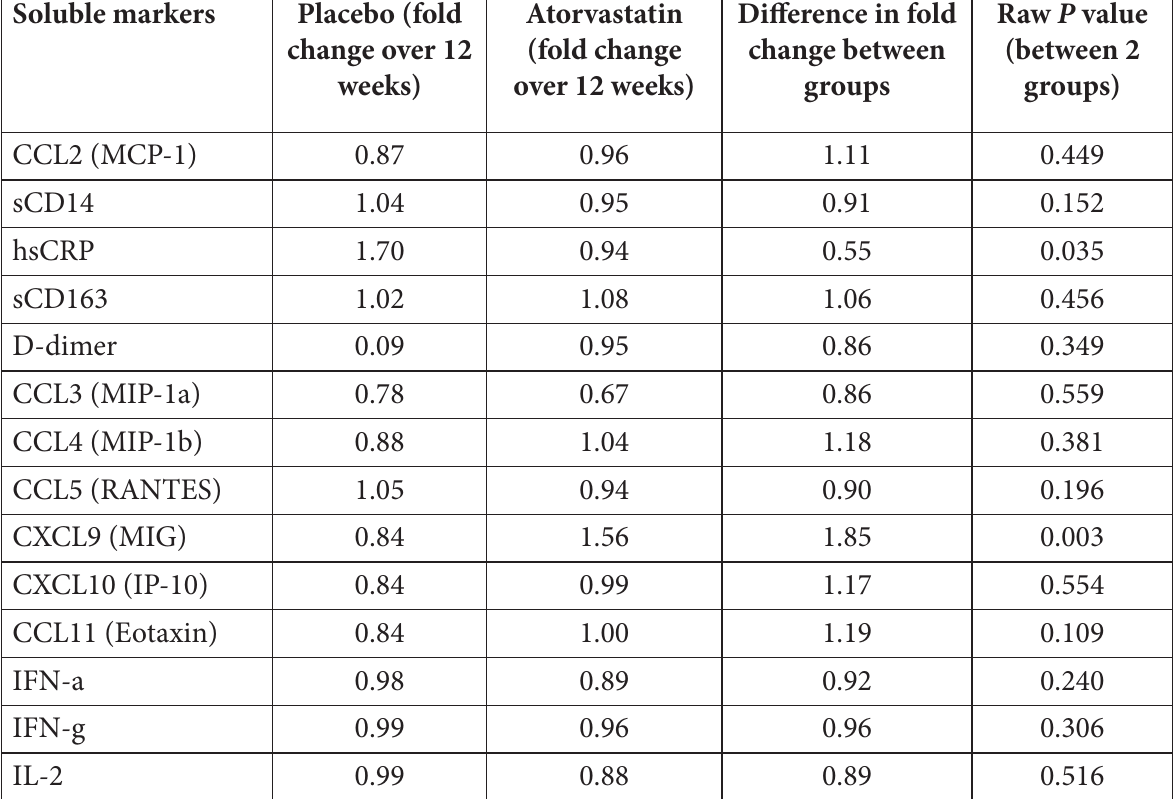
Table 3. Change in plasma markers over 12 weeks of atorvastatin or placebo treatment Soluble markers Placebo (fold